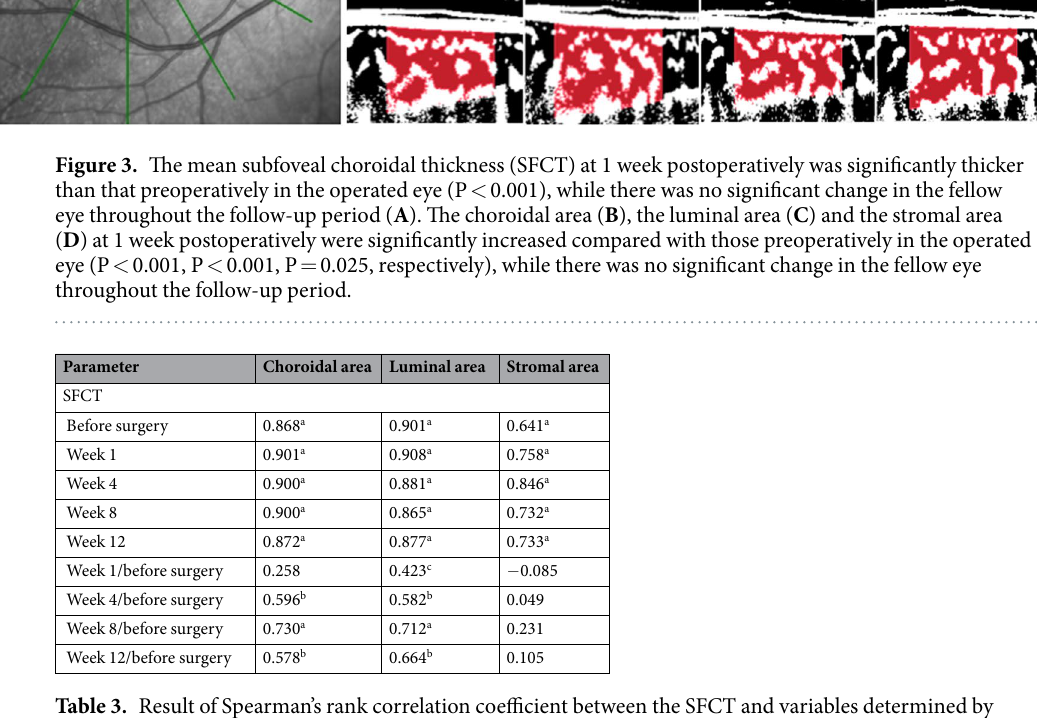
Table 3. Result of Spearman’s rank correlation coefficient between the SFCT and variables determined by binarization method. SFCT = subfoveal choroidal thickness. a p < 0.001, b p < 0.01, c p <